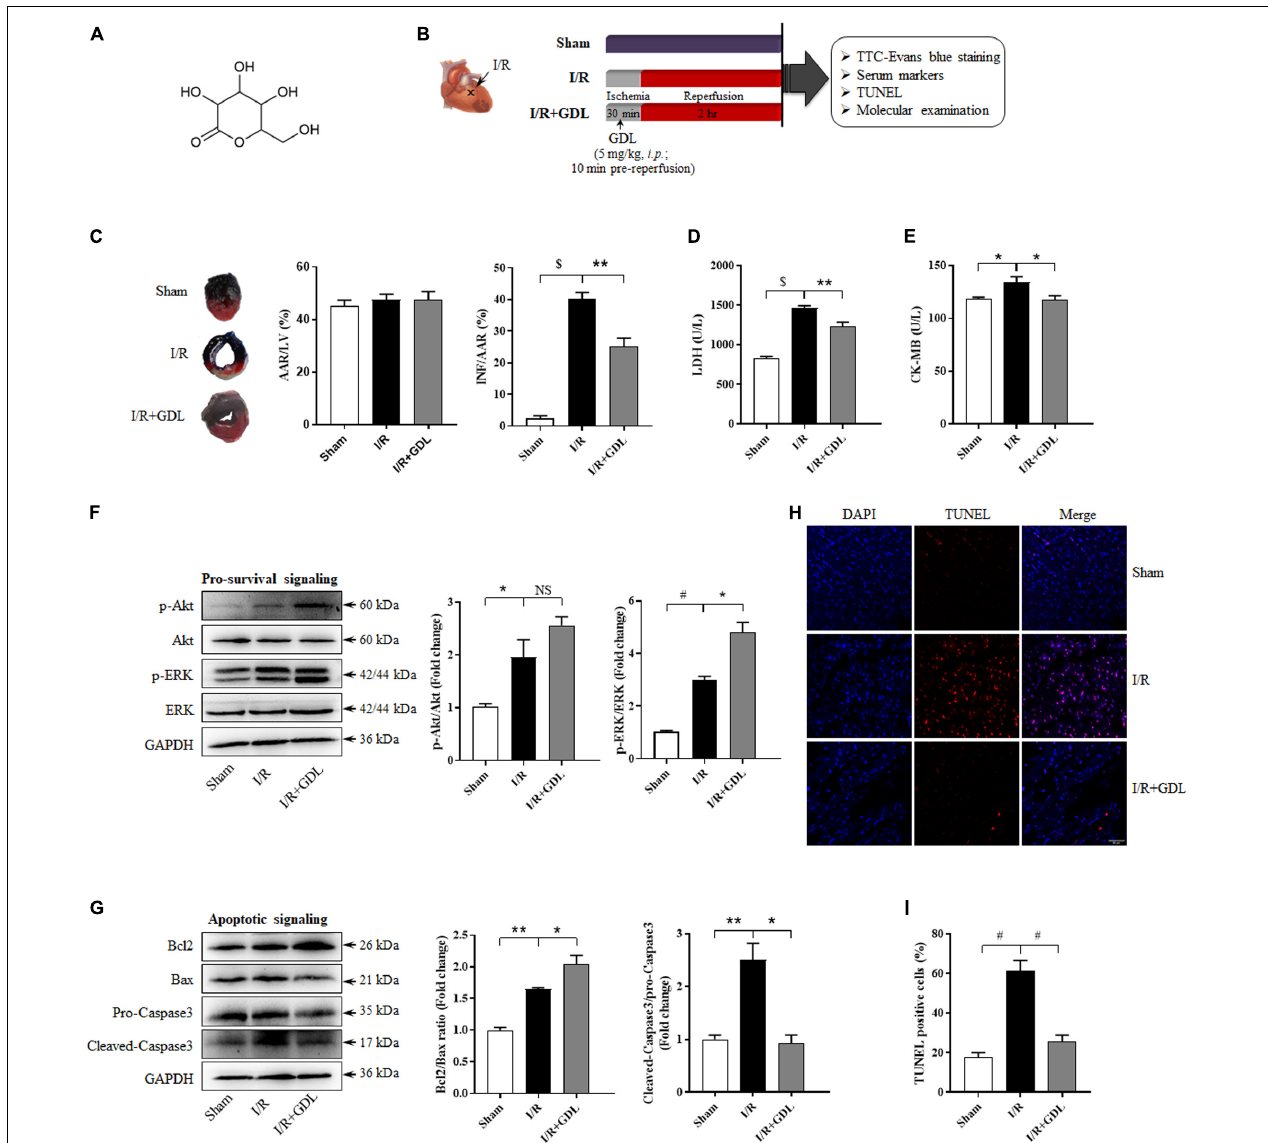
FIGURE 1 | D-glucono-1,5-lactone protected against myocardial ischemia/reperfusion injury in mice. (A) The chemical structure of GDL. Mice were randomly divided into three groups: Sham, I/R group, and I/R + GDL group. (B) The schematic of the experimental design in vivo . (C) Myocardial infarction was assessed by TTC-Evans blue double staining ( n = 5). (D) Serum LDH and (E) CK-MB activities were evaluated as an index for cardiac injury via commercial kits ( n = 8–12). (F) Representative images and Western blot analysis of pro-survival kinases (ERK and Akt) in cardiac tissues of each group ( n = 5). (G) Representative images and Western blot analysis of apoptosis-related proteins (Bcl2, Bax, and Caspase3) in cardiac tissues of each group ( n = 5). (H–I) TUNEL staining and quantification of apoptosis in heart tissue section among groups ( n = 5; scale bar = 50 µ m). * P < 0.05, ** P < 0.01, # P < 0.001, and $ P < 0.0001 between indicated